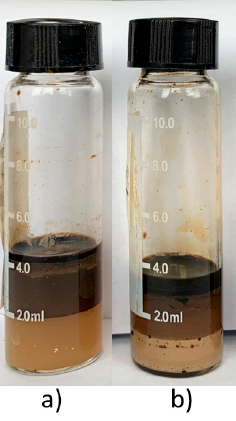
Figure 1. Results of phase behavior study for ( a ) EW-surfactant solution and ( b ) EW-surfactant solution with addition of 1 wt% alkali.